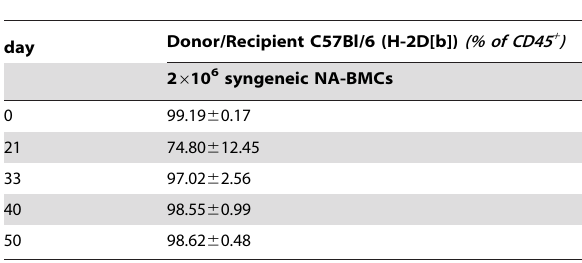
Table 3. Analysis of donor/recipient C57Bl/6